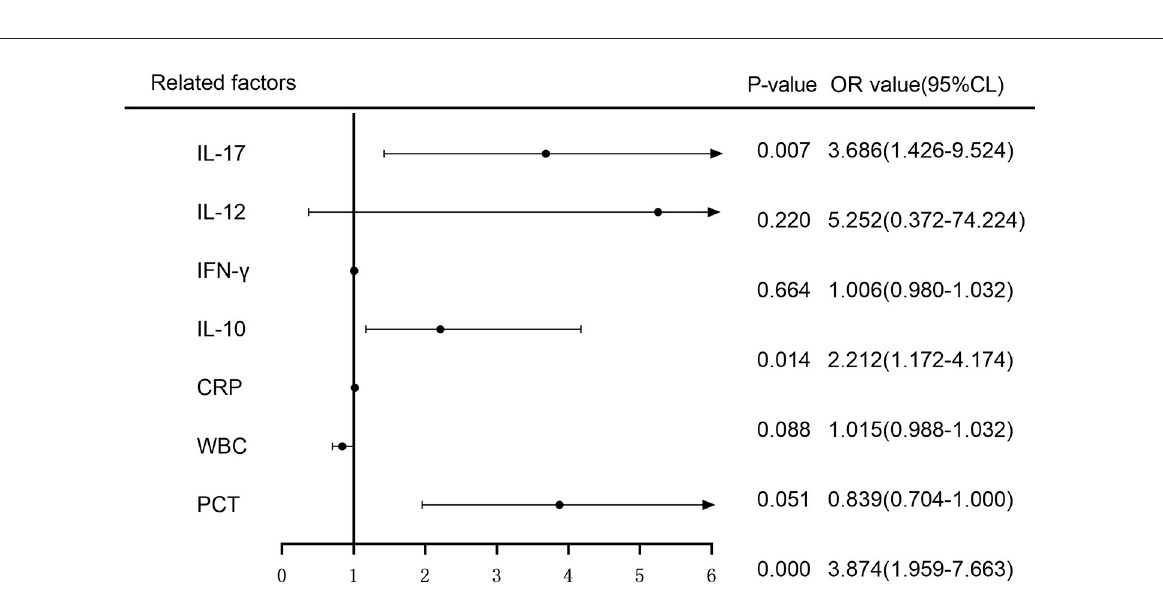
interleukin-8 (IL-8), interleukin-10 (IL-10), interleukin-12 (IL- 12), interleukin-17 (IL-17), tumor necrosis factor-a (TNF- α